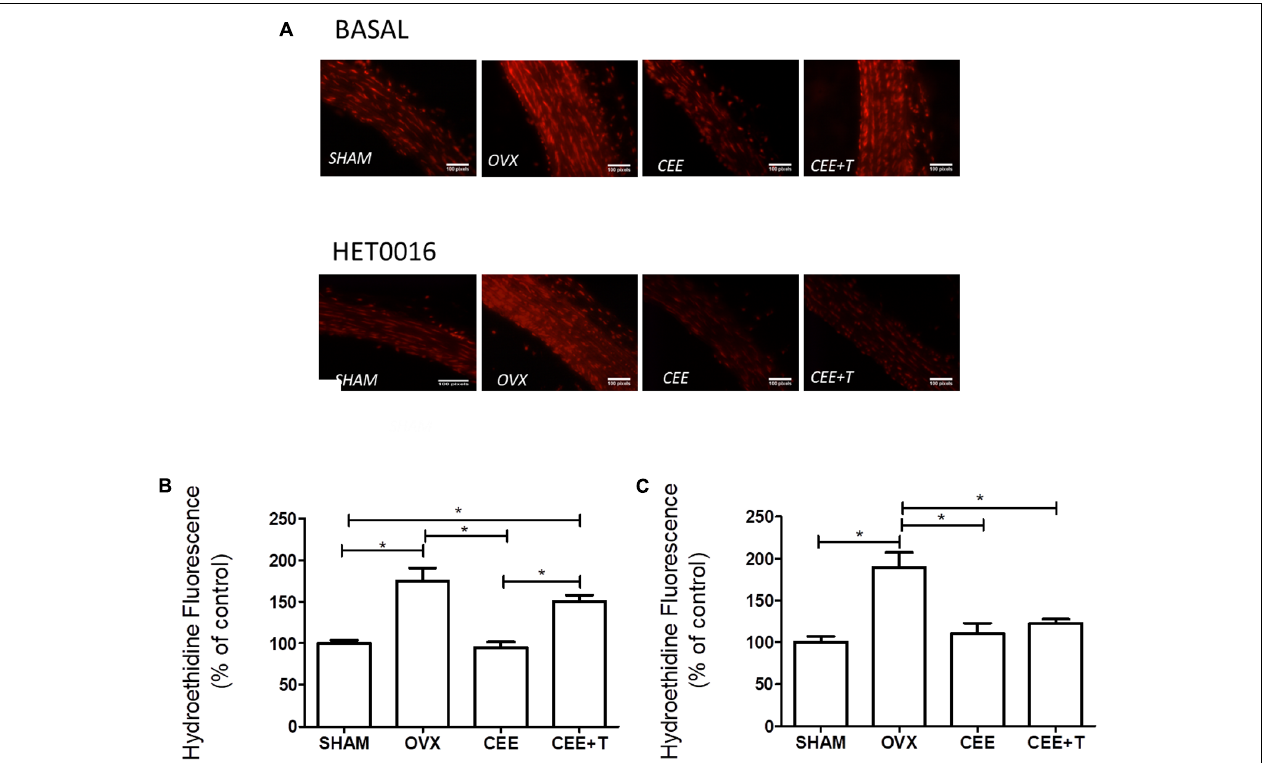
FIGURE 3 | Representative fluorescent images (A) of nuclei labeled with ethidium produced by oxidation of dihydroethidium (DHE) by reactive oxygen species in aortic sections of SHAM, ovariectomized (OVX), OVX treated with conjugated equine estrogens (CEE) and OVX treated with CEE plus testosterone (CEE+T) female spontaneously hypertensive rats. Bar graphs show the densitometric analyses of fluorescence intensity of arteries after treatment with vehicle (B) and 1 µ M of HET0016, the CYP4A and CYP4F inhibitor (C) . Results were expressed as percentage of SHAM and represent the mean ± SEM from 6–8 independent experiments. One-way ANOVA: ∗ P < 0.05.